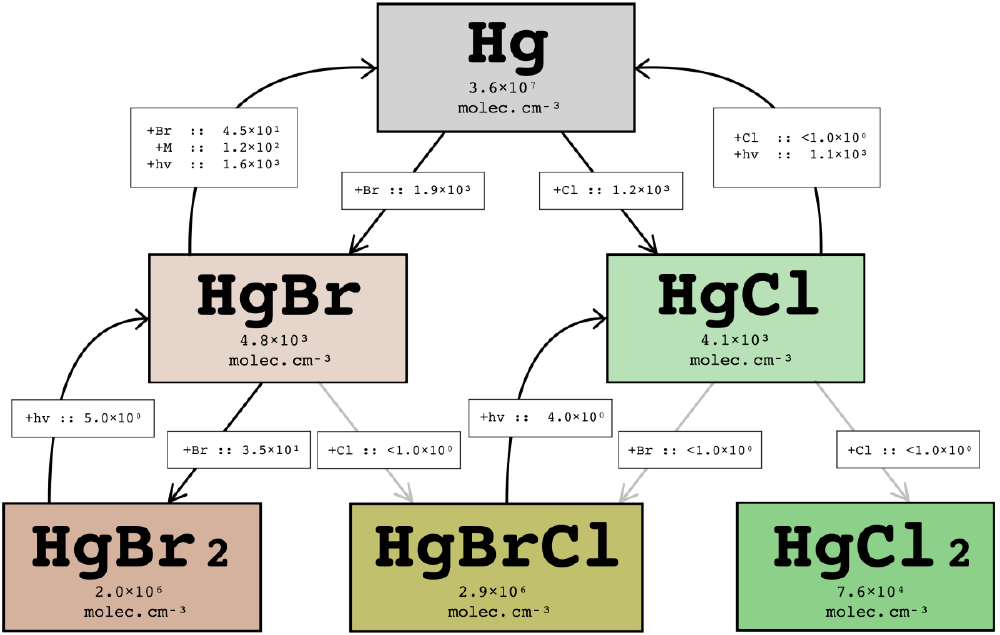
Figure 18. Instantaneous average in-plume concentrations and reaction rates (in molec. cm − 3 s − 1 ) for the Hg cycle for the part of the plume aged 40–50min on 1 August 2012 at 12:00UTC. Rates less than 1molec.cm − 3 s − 1 are written as < 1 . 0 × 10 0